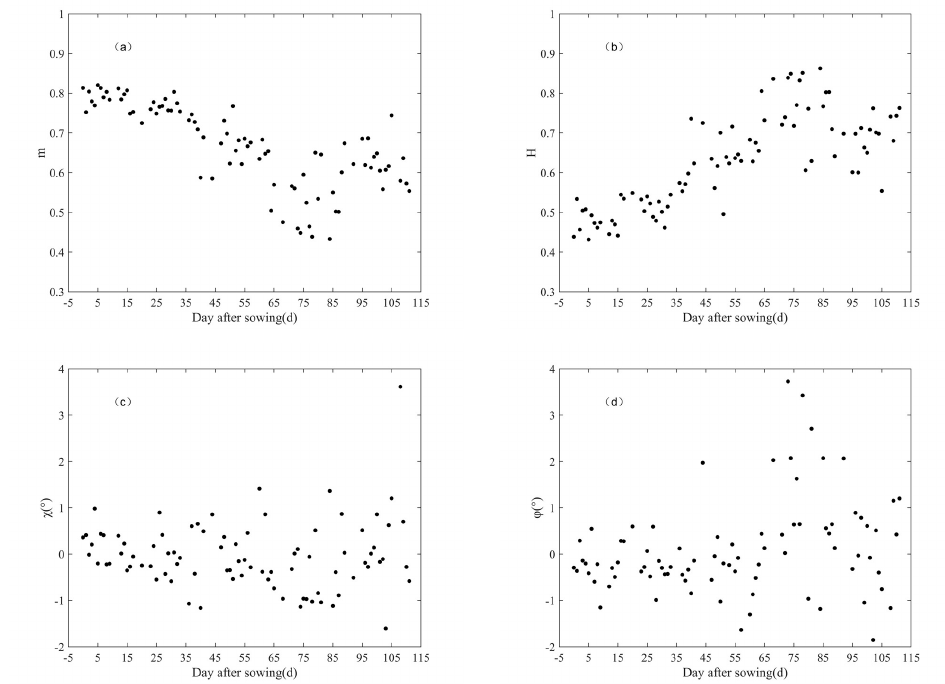
Figure 6. The evolution of m , H , χ and ϕ in Group 1 versus rapeseed phenology.